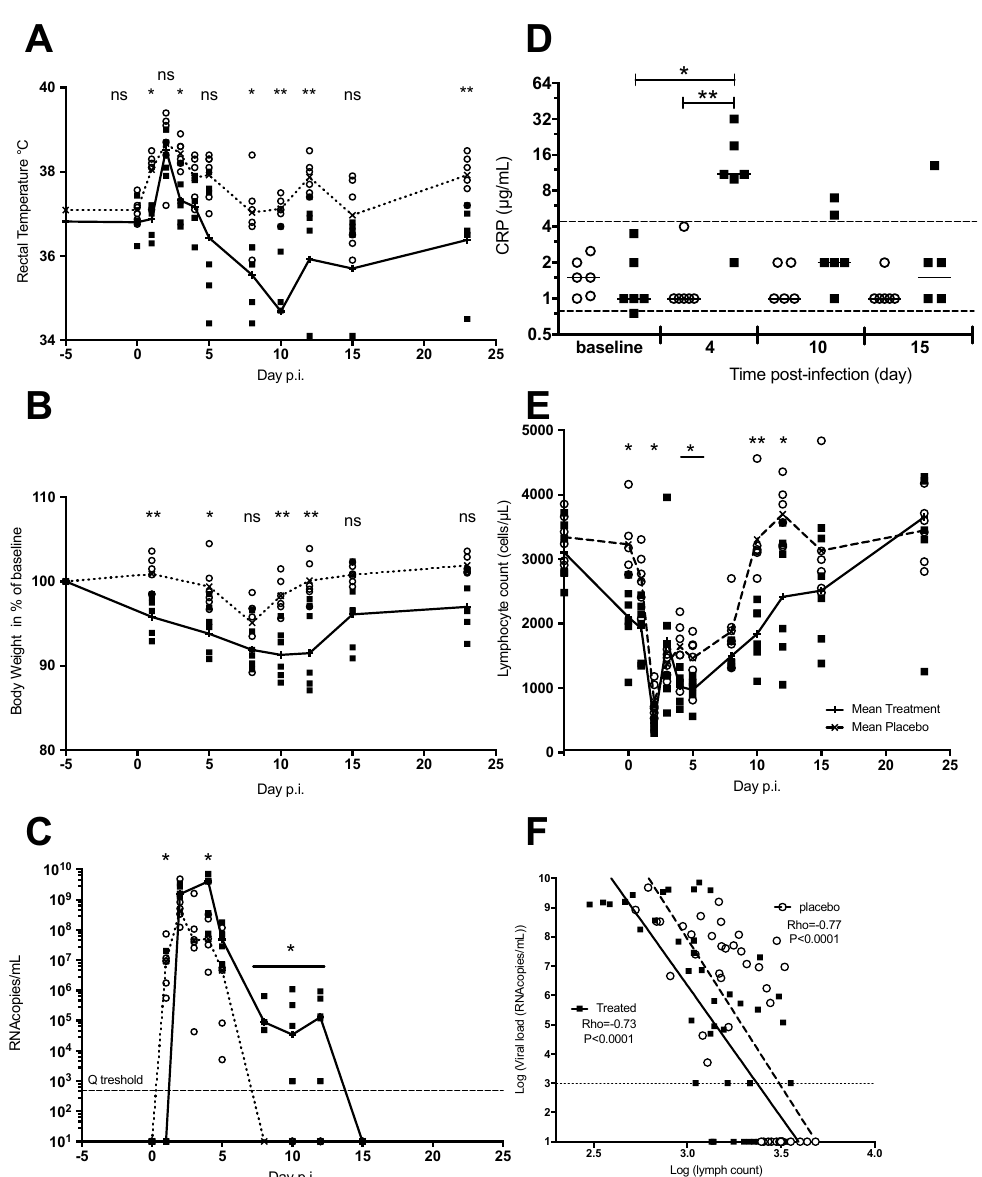
Figure 2. Exacerbation of acute chikungunya in macaques that were treated with chloroquine. Macaques randomly assigned to the placebo ( n = 6, open circles, median shown as a dotted line) or chloroquine ( n = 6, closed squares, median shown as a solid line) groups were treated for five days before infection with CHIKV. Treatment was then continued for 10 days. ( A ) Fever and hypothermia, as determined by measurements of rectal temperature; ( B ) Body weight loss in treated animals (percentage of baseline); ( C ) Plasma viral load, as measured by RT-qPCR; ( D ) CRP determination in plasma (* p < 0.05 Wilcoxon rank test). Global analysis by Kruskal-Wallis test, p = 0.0144 for the chloroquine group, not significant for the placebo group. The two dotted lines indicate the normal range of plasma CRP levels that were obtained from 15 healthy macaques; ( E ) Lymphopenia, as assessed by lymphocyte count kinetics; ( F ) Absolute lymphocyte counts are correlated with plasma viral load during acute chikungunya (Spearman’s rank correlation test). Mann & Whitney test when comparing placebo and treated animals; ns: not significant. * p < 0.05; ** p < 0.01. Wilcoxon rank test p values, for comparing the data at a given time point with baseline values (before treatment), are given in the text. Dotted horizontal line in C and F are the lower limit of quantitation by Q-RT-PCR.